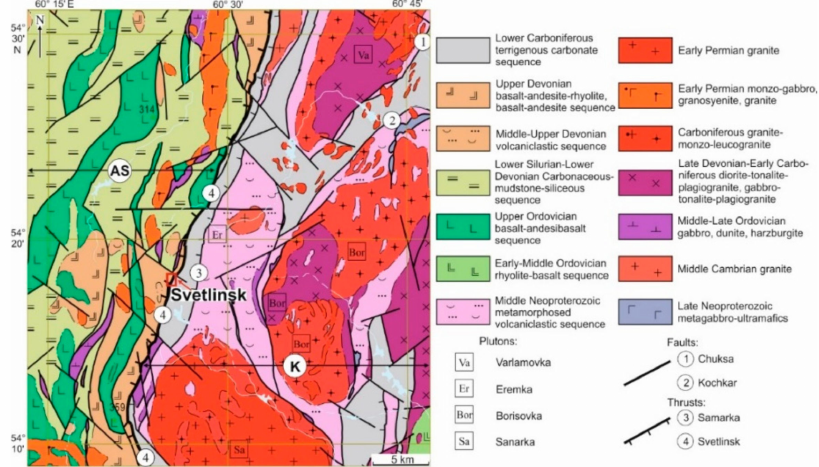
Figure 2. Geological setting of the mineralising district comprising the Svetlinsk gold deposit, modified after[33]. TheredsquarecorrespondstotheSvetlinskgolddeposit(Figure3). K—Kochkaranticlinorium zone. AS—Aramil-Sukhtel synclinorium